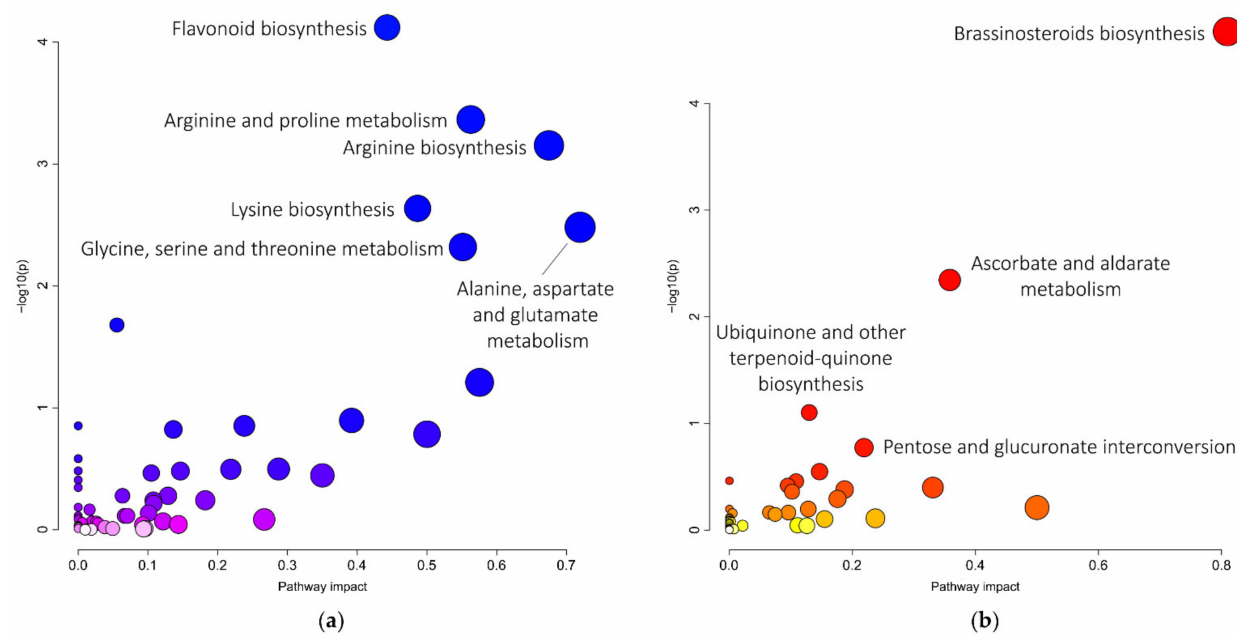
Figure 1. KEGG metabolic pathway enrichment and pathway topology analysis. Over-represented KEGG metabolic pathways in bean nodules colonized by P. phymatum wild-type compared to nodules colonized by P. phymatum nifA mutant ( a ) and over-represented in nifA compared to wild-type nodules ( b ). The metabolites used for this representation display different levels in both types of nodules (absolute log 2 FC < 0.5 and q -values ≤